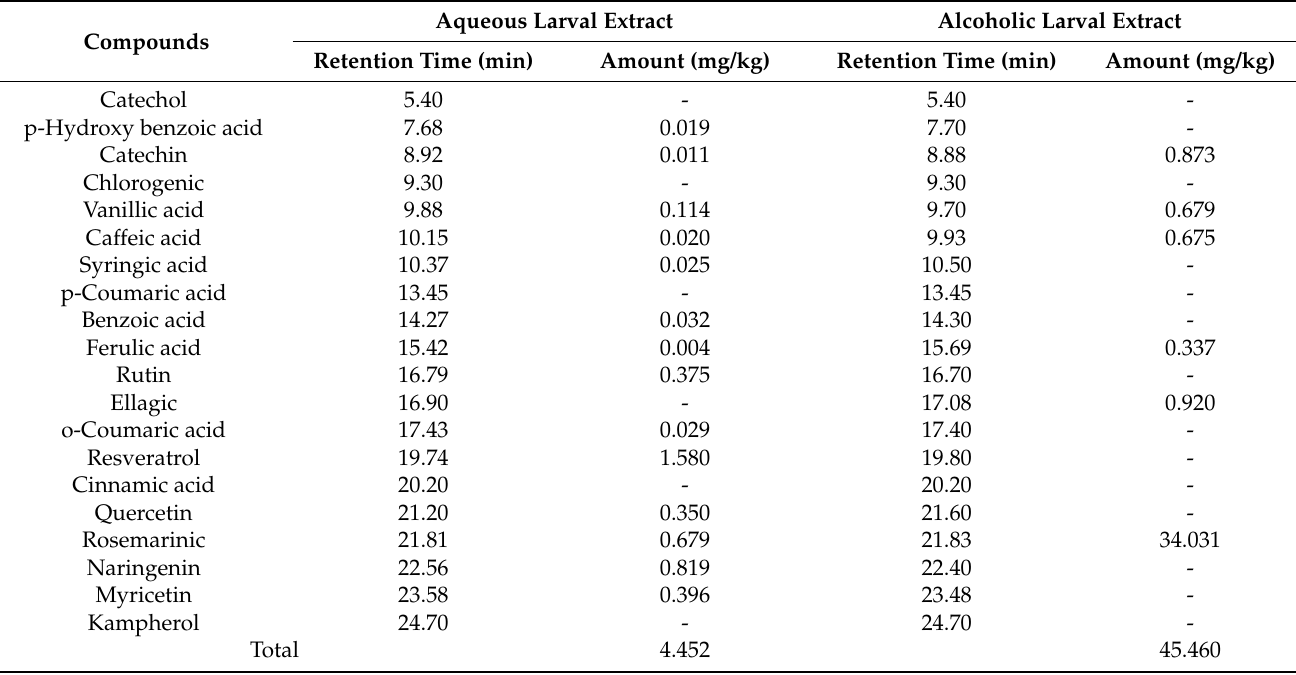
Table 2. Flavonoids and phenolic compounds composition of 5% aqueous and alcoholic larval extracts.